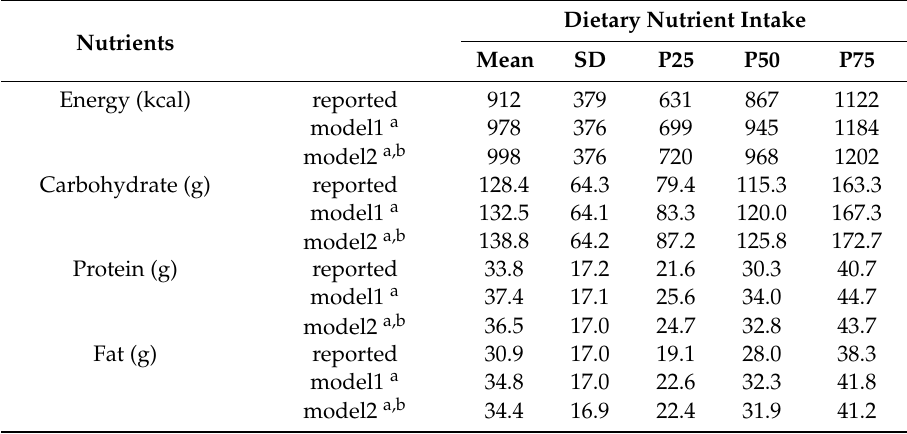
Table 3. Comparing reported daily energy and nutrient intakes with the addition of cow’s milk (model 1) and a new young children formula (model 2) in children aged 12–36 months who did not meet the dairy intake recommendations (N =